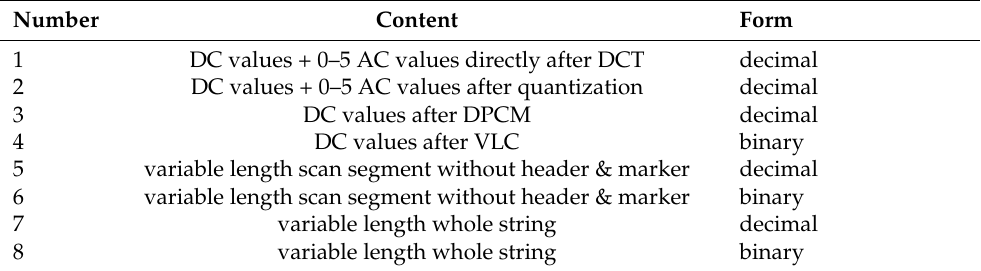
Table 4. All eight datasets from different stages during JPEG compression. Input streams are either decimal numbers or binary numbers.